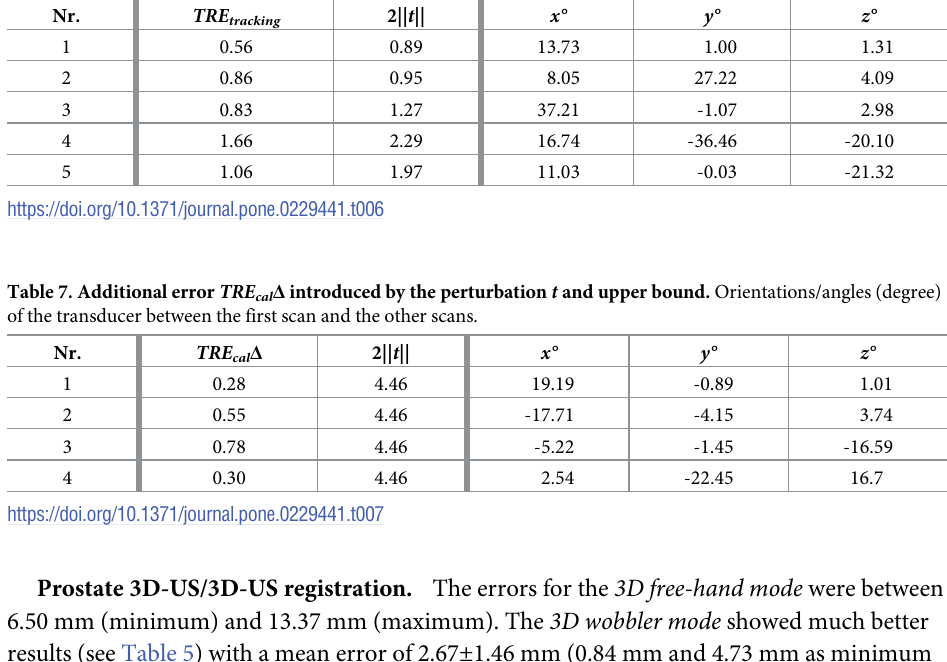
Table 6. TRE tracker and theoretical upper bound. Rotation of the transducer relative to the reference tool. Nr.